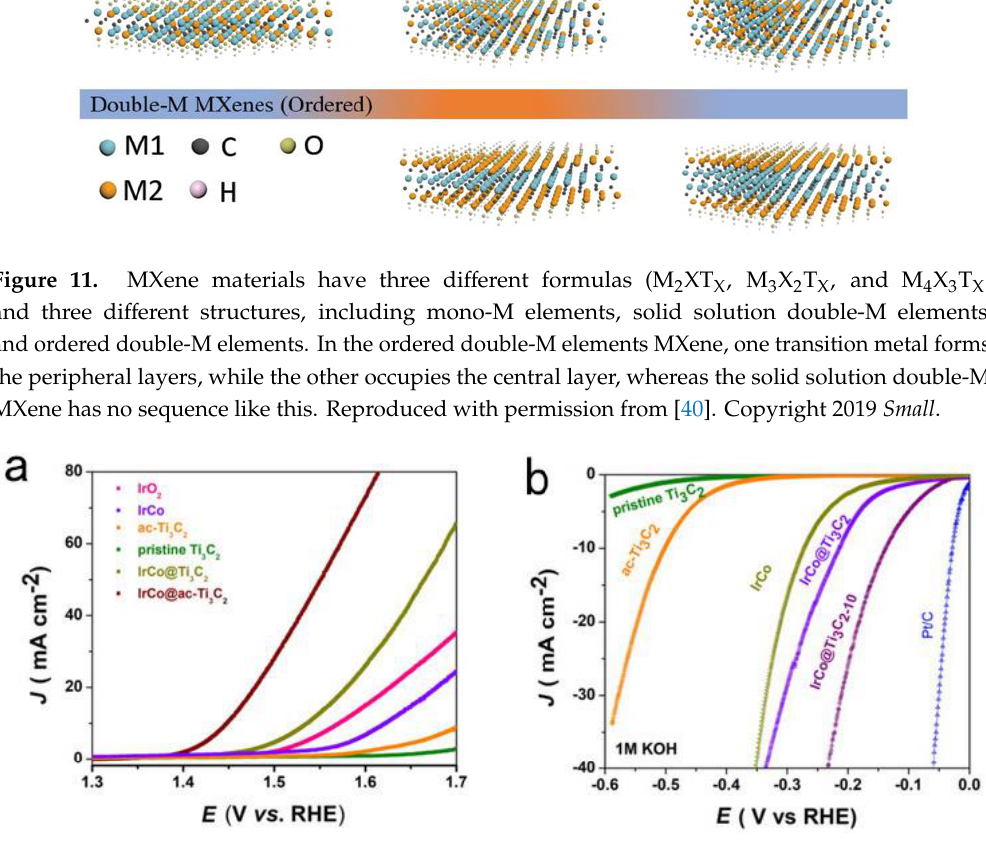
Figure 12. ( a ) OER and ( b ) HER IR-corrected polarization curves of IrCo@ac-Ti 3 C 2 with a scan rate of 10 mV/s in 1.0 M KOH that demonstrate its bifunctional ability. Reproduced with permission from